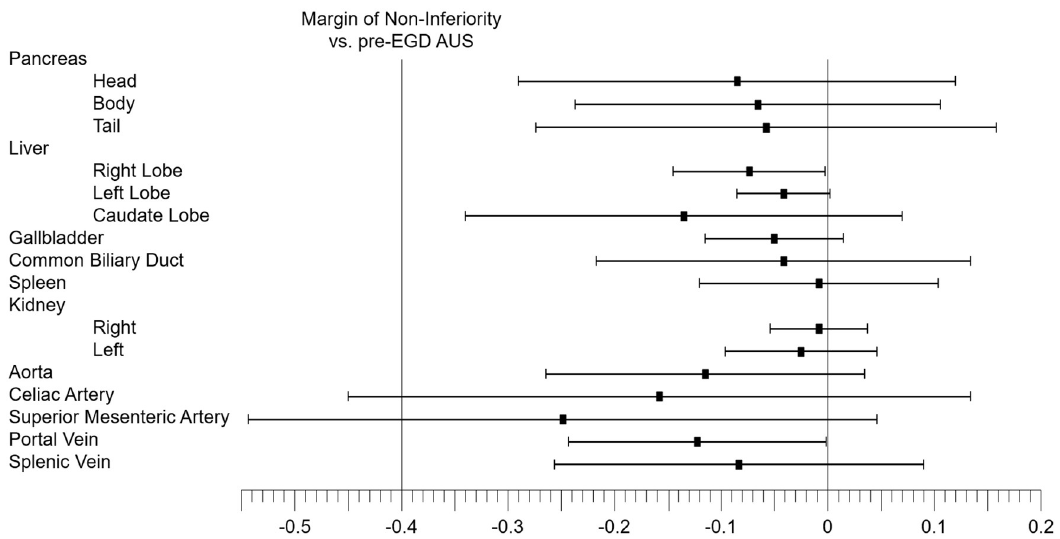
Fig 3. Non-inferiority test of post-EGD AUS in each organ. The results of the non-inferiority test of the post-EGD AUS in each organ, depicted as the difference in image quality score between the post- and pre-EGD